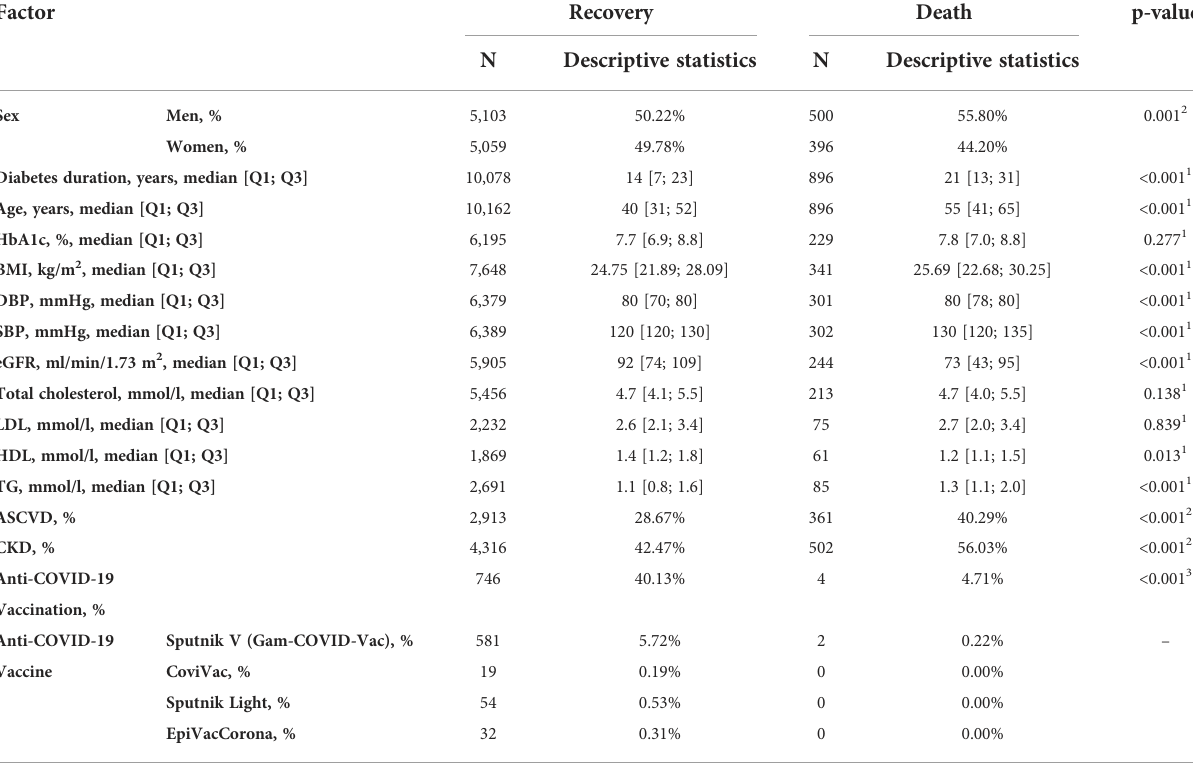
TABLE 1 Clinical characteristics of T1DM patients according to the outcome (death/recovery) (n = 11,058).